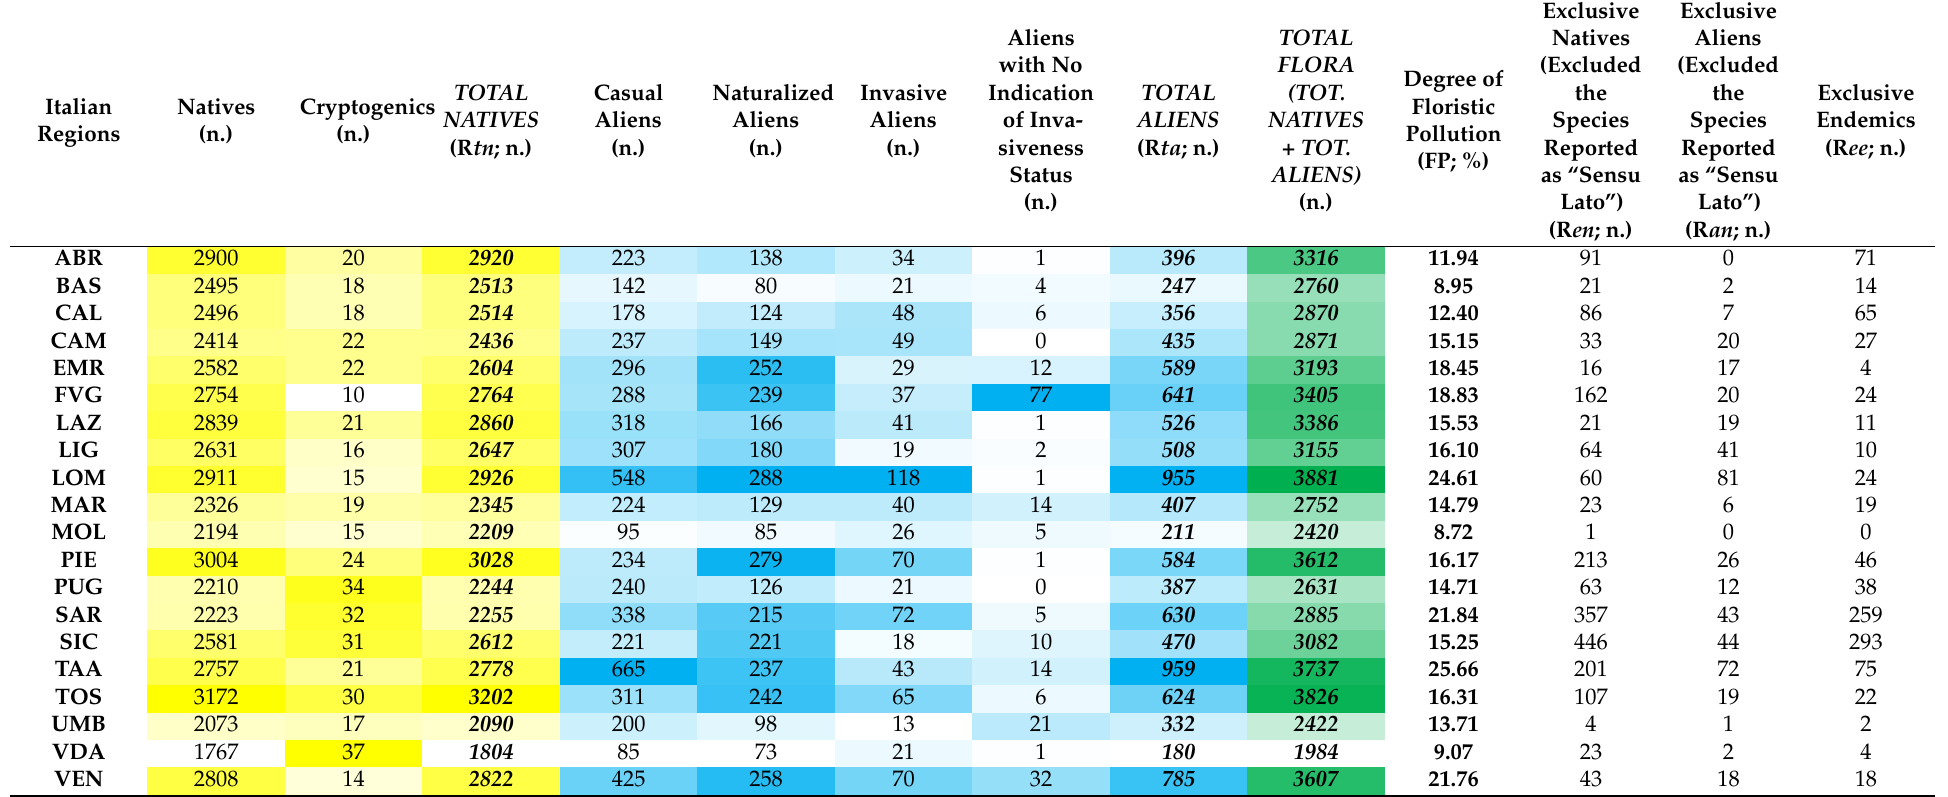
Table 2. Currently occurring floristic composition of Italian regions (ABR: Abruzzo; BAS: Basilicata; CAL: Calabria; CAM: Campania; EMR: Emilia-Romagna; FVG: Friuli-Venezia Giulia; LAZ: Lazio; LIG: Liguria; LOM: Lombardia; MAR: Marche; MOL: Molise; PIE: Piemonte; PUG: Puglia; SAR: Sardegna; SIC: Sicilia; TOS: Toscana; TAA: Trentino-Alto Adige; UMB: Umbria; VDA: Valle d’Aosta; and VEN: Veneto). Gradients of yellow, blue and green indicate the richness of native taxa (including certainly natives and cryptogenics), alien taxa (including casual, naturalized, invasive and not assessed aliens) and total taxa in each region, respectively. Taxa reported by mistake and as doubts, data deficient, extinct and no longer recorded after 1950 are not